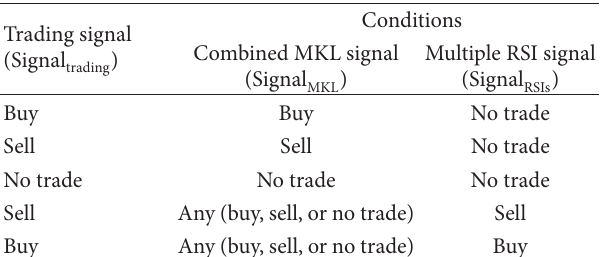
Table 5: Conditions that need to be satisfied before issuing the trading signal.